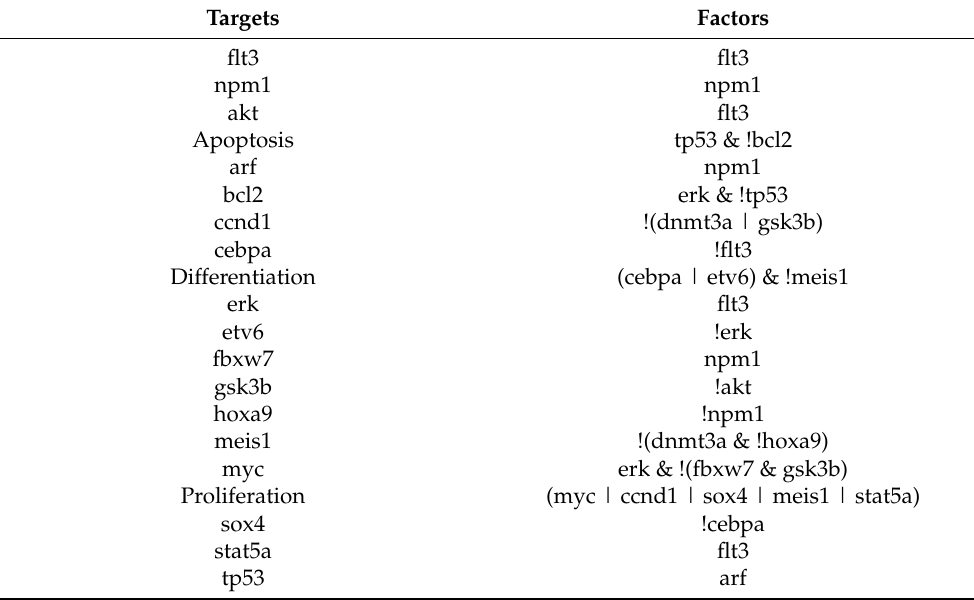
Table A1. The NPM1, DNMT3A, FLT3 Boolean